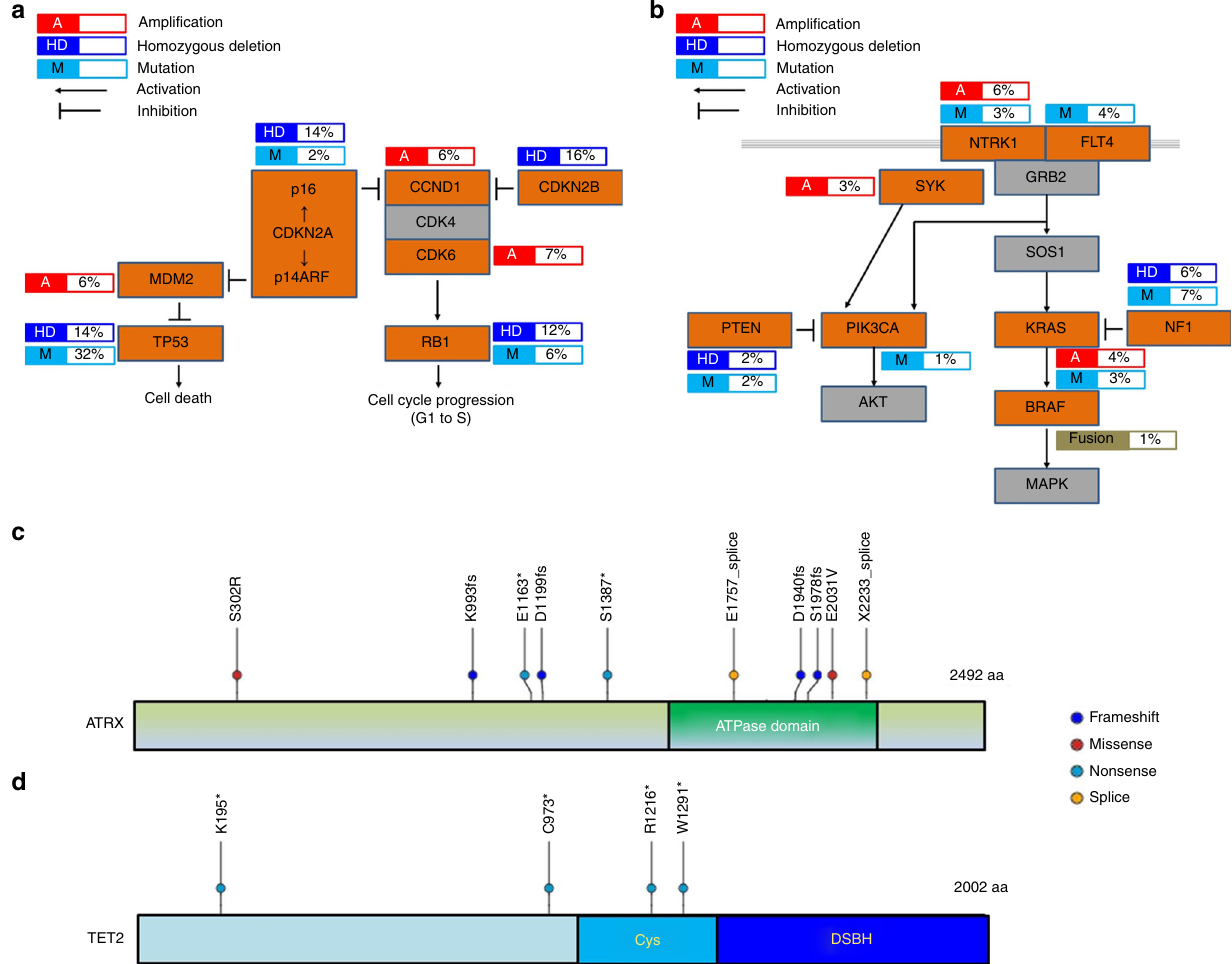
Fig. 2 Recurrently altered pathways and genes in MFS. Frequently altered pathways in MFS: p53 signaling and cell cycle G1/S checkpoint pathways ( a ) and RTK-RAS-PI3K pathway ( b ). Genes with alterations are colored in orange. The types of alterations (ampli fi cation, homozygous deletion, or mutation) and their frequencies are indicated. Distributions of mutations of ATRX ( c ) and TET2 ( d ) detected in 116 MFSs were shown. The location of somatic mutations in ATRX or TET2 observed in this study is shown on the protein schematics. Types of mutations are featured by color as follows: frameshift indel, blue; missense, red; nonsense, light blue; and splice site, orange. The majority of mutations in ATRX were loss-of-function alterations that presumably lack the ATPase domain ( c ). All four nonsense mutations in TET2 are predicted to encode truncated proteins lacking a functional DSBH domain ( d ). Cys